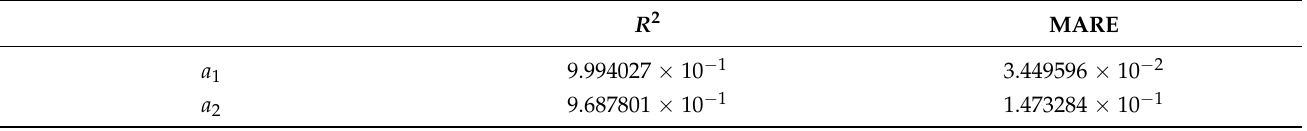
Table 3. Numerical verification results of the constructed Kriging models with the testing